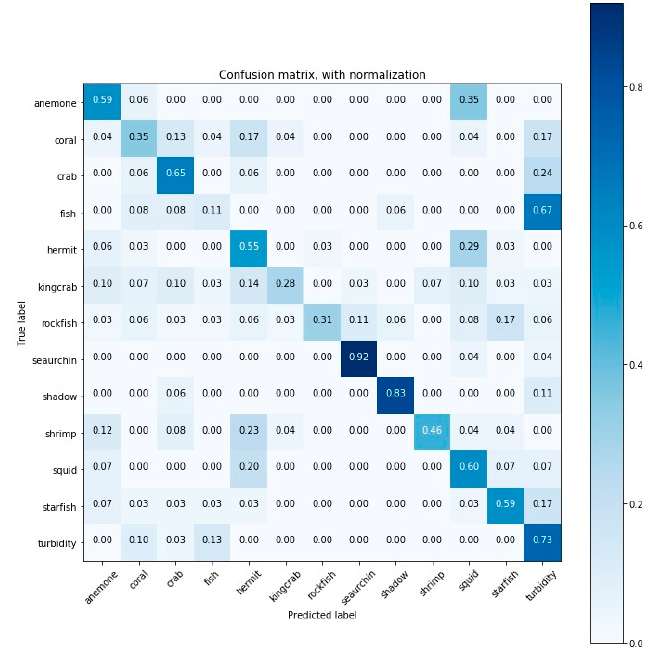
Figure A2. Confusion matrix for the classification results (accuracy) obtained by linear support vector machine and stochastic gradient descent (LSVM + SGD).